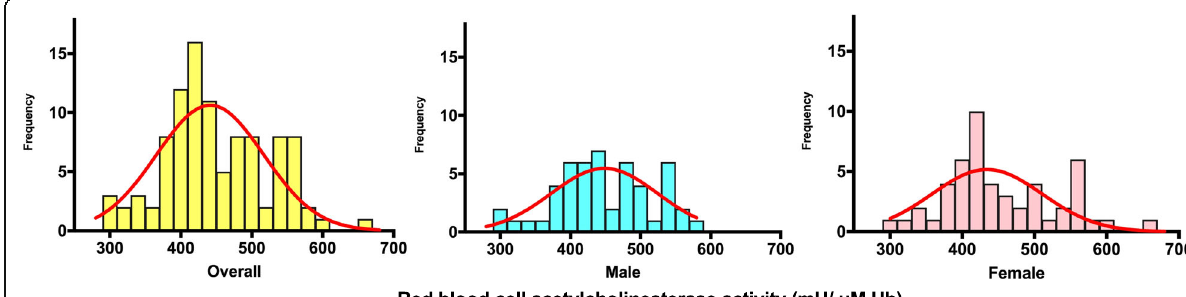
Fig. 1 Distribution of acetylcholinesterase activity among healthy non-farmers of Anuradhapura, 2017